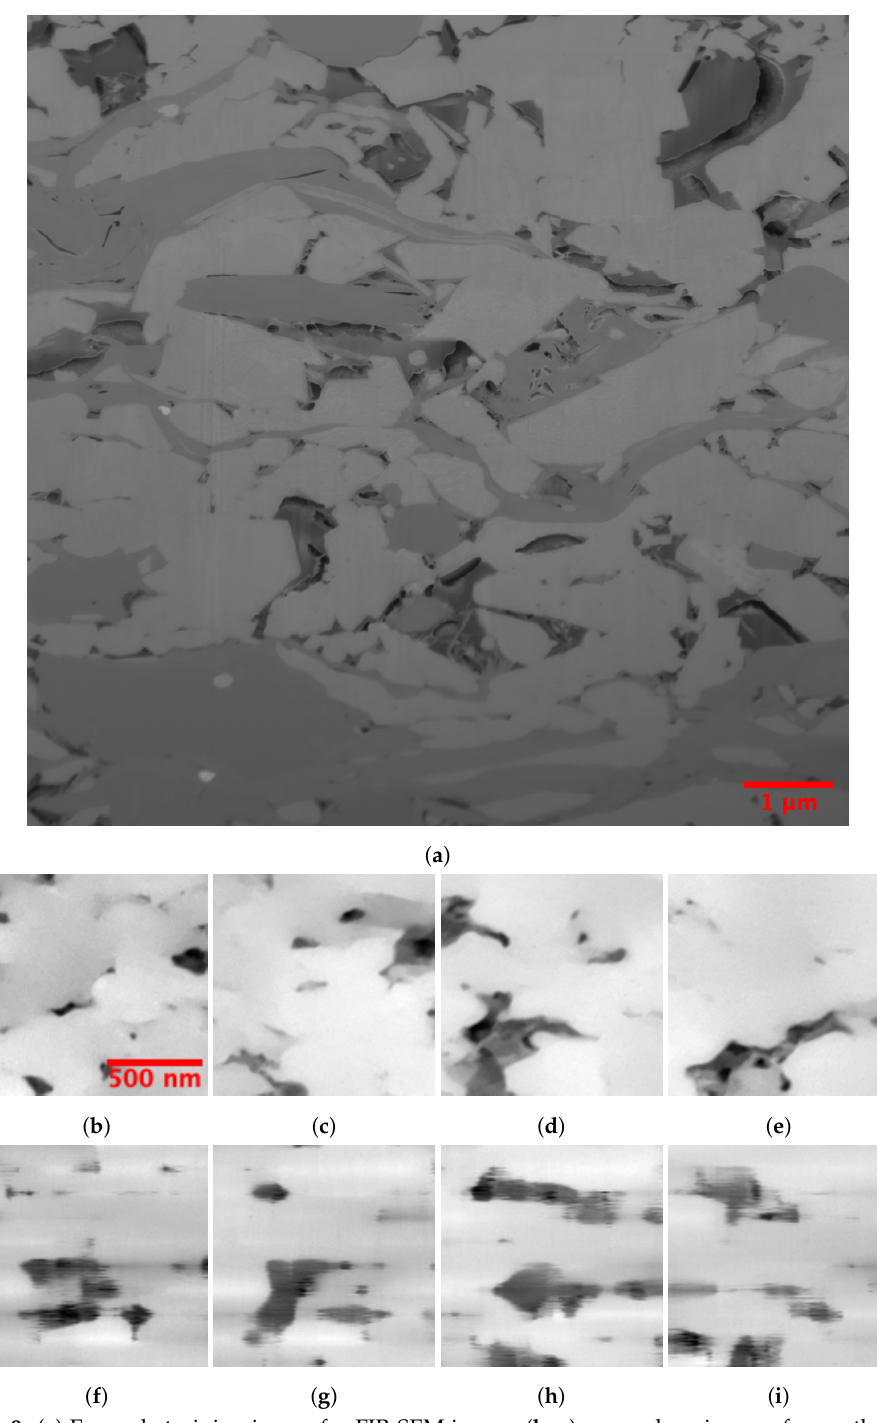
Figure 9. ( a ) Example training image for FIB-SEM image, ( b – e ) x − y plane images for synthesized image volume, and ( f – i ) x − z plane images for synthesized image volume: the sampled images are 128 × 128 px patches. All images have 9.39 × 8.97 nm/voxel resolution in the x − y